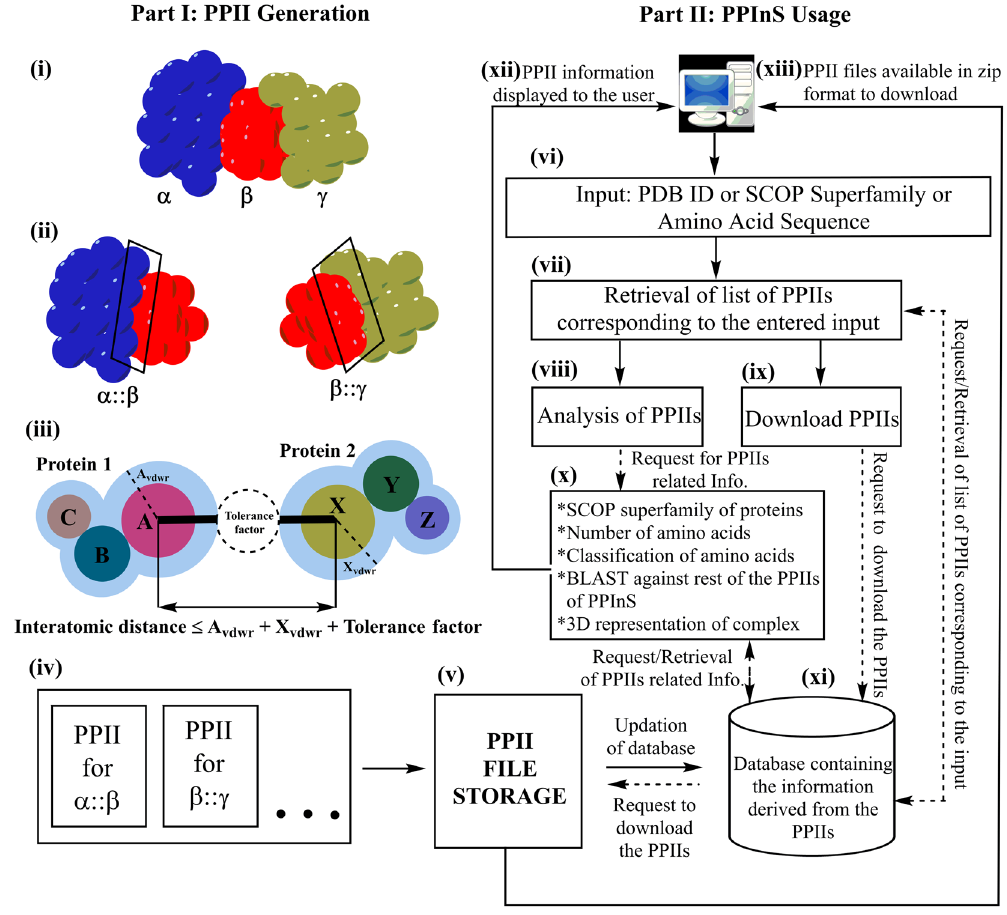
Figure 4. Overview of